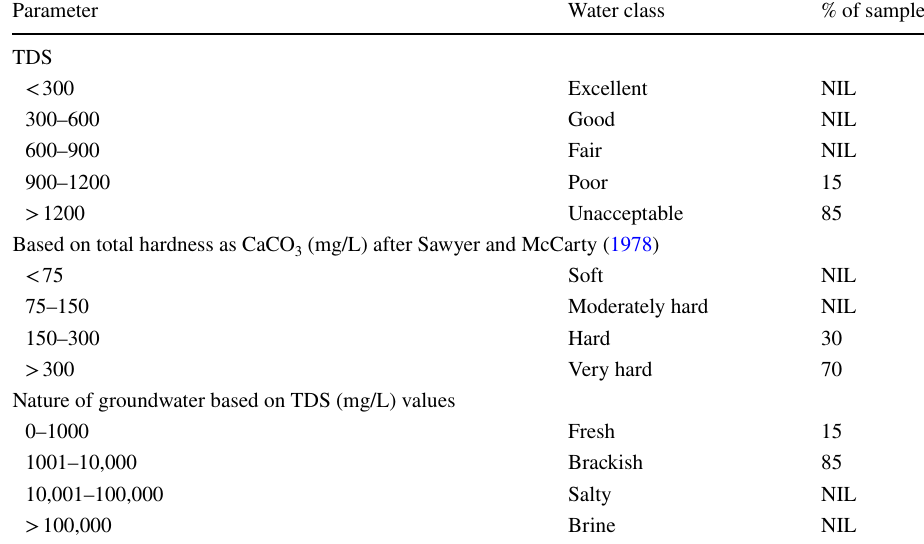
Table 3 Suitability of groundwater for drinking based on many classifications